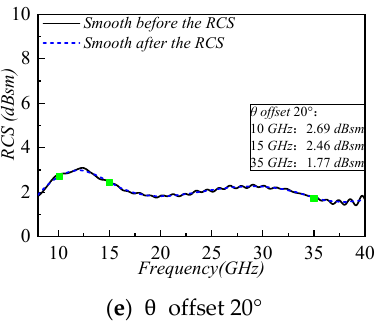
Figure 5. Simulation results of the loading TCR (side length a = 200) of the metasurface based on resistive film technology at various incident angles.